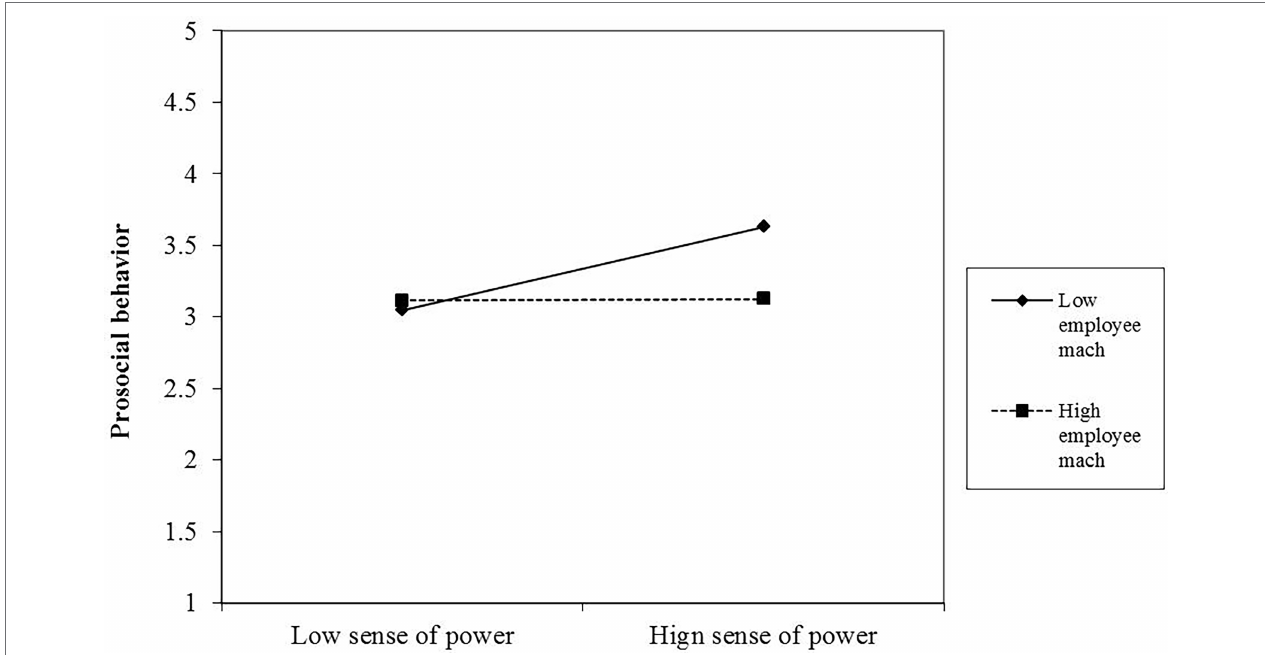
FIGURE 3 | Moderating effect of followers’ Machiavellianism between a sense of power and prosocial